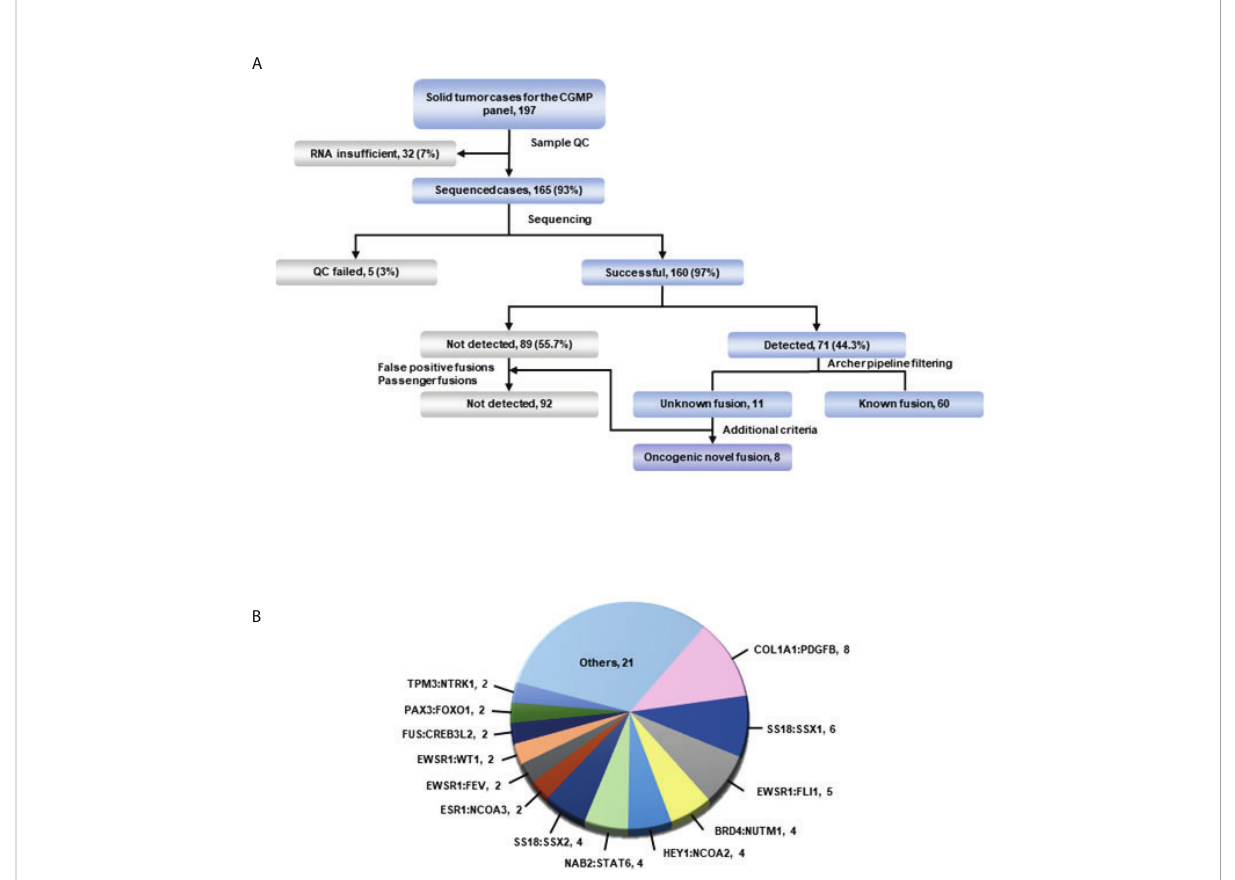
FIGURE 1 Overview of targeted sequencing. (A) Schematic of the process. All fusions were detected in the Archer pipeline. The green line represents con fi rmation of detected fusions with the Arriba fusion caller. (B) Fusions and their count detected in more than 2 cases in targeted RNA sequencing. Fusions from only one case were included in